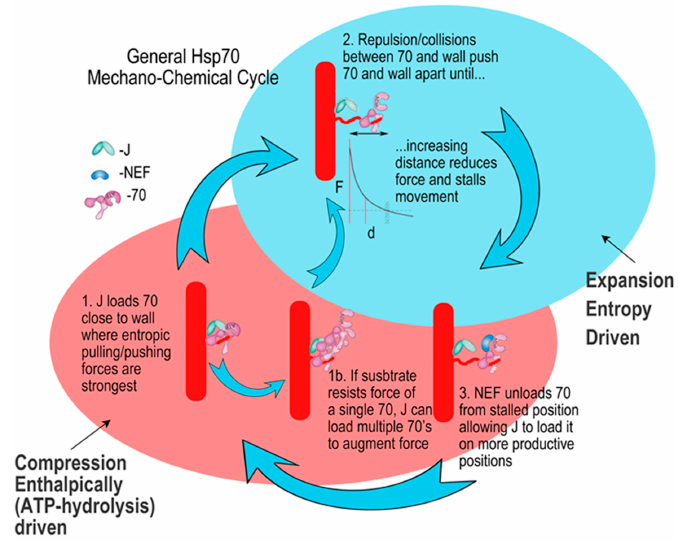
Figure 3. The general Hsp70 mechanochemical cycle can be analogized to a compressed gas cooling system. In the energy consuming compression phase, a J cochaperone loads Hsp70*ATP onto a peptide tether adjacent to constraining protein walls and the ATP is hydrolyzed. In the entropy driven expansion phase the J cochaperone releases the Hsp70*ADP, and collisions / repulsive interactions drive Hsp70 and the walls apart. Forces diminish as the distance between Hsp70 and the walls grows, until a nucleotide exchange factor (NEF) induces ADP dissociation so that ATP can bind and drive release of Hsp70 from the peptide tether, resetting the cycle. Adapted from ref.